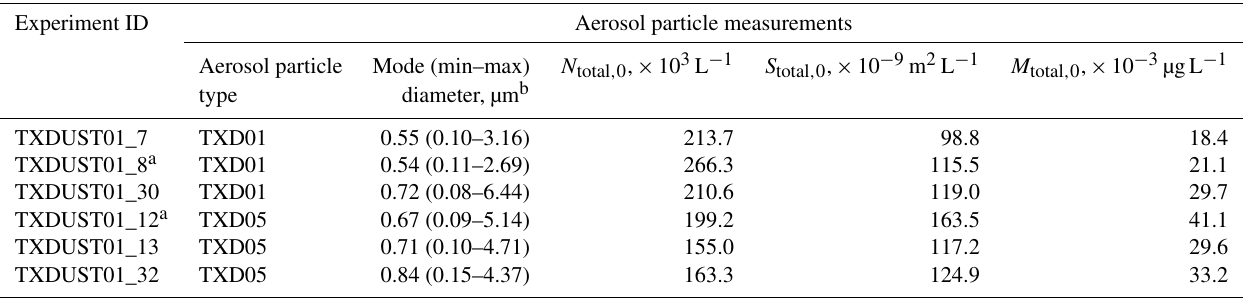
Table 1. Characterization of particle properties: assessed prior to AIDA expansion experiments. Experiment ID Aerosol particle